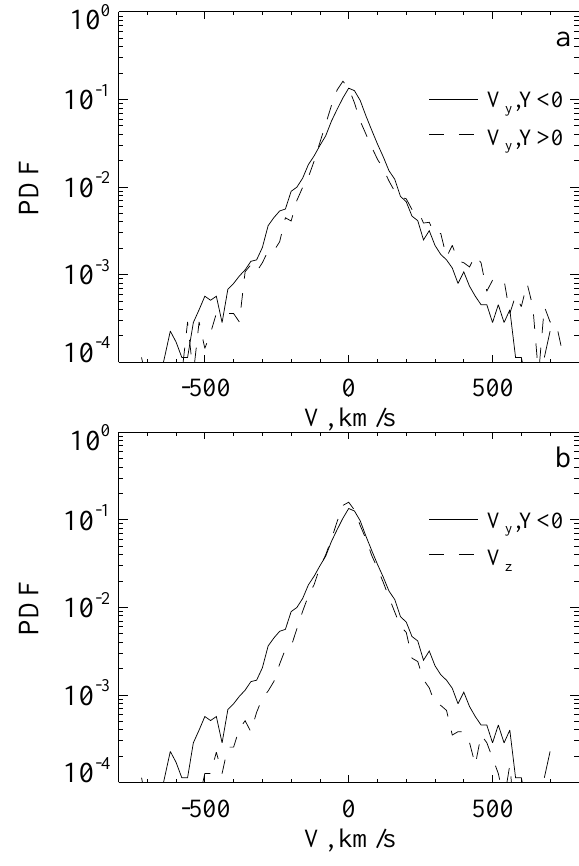
Fig. 1. Positions of the Interball-Tail plasma sheet measurements: XY (a) and XZ (b) GSM planes.